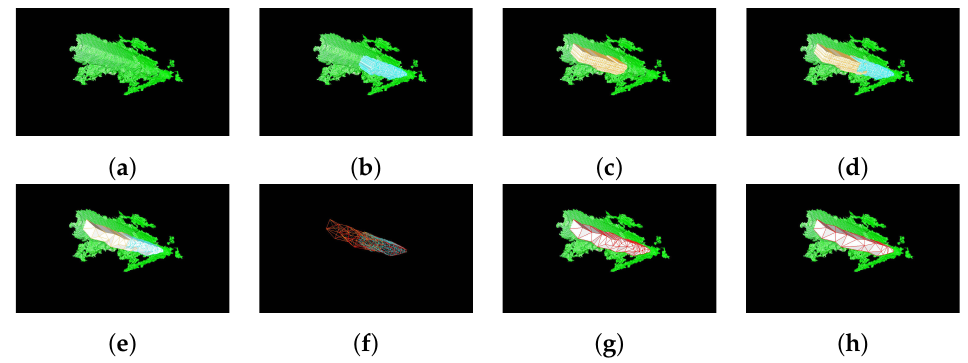
Figure 13. Steps for geometry generation of spalling defect. ( a ) Triangulated mesh of the 3D reconstructed point cloud via OpenSfM. ( b ) Extrusion of the triangulated labeled defect patch in Figure 12d along the mean conformed unit normal direction. ( c ) Extrusion of the triangulated labeled defect patch in Figure 12h along the mean conformed unit normal direction. ( d ) Both extruded patches are added together. ( e ) Resultant geometry of mesh decimation for both extruded batches. ( f ) The output of the boolean union operation of both extruded patches displayed in wire-frame view mode. ( g ) The output of the boolean union operation displayed as a solid geometry. ( h ) The final simplified geometry generated for the segmented defect to further reduce its number of